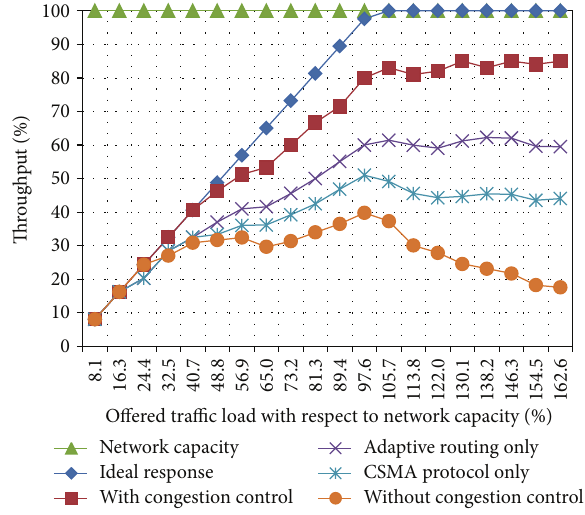
Figure 2: Throughput versus offered traffic load.